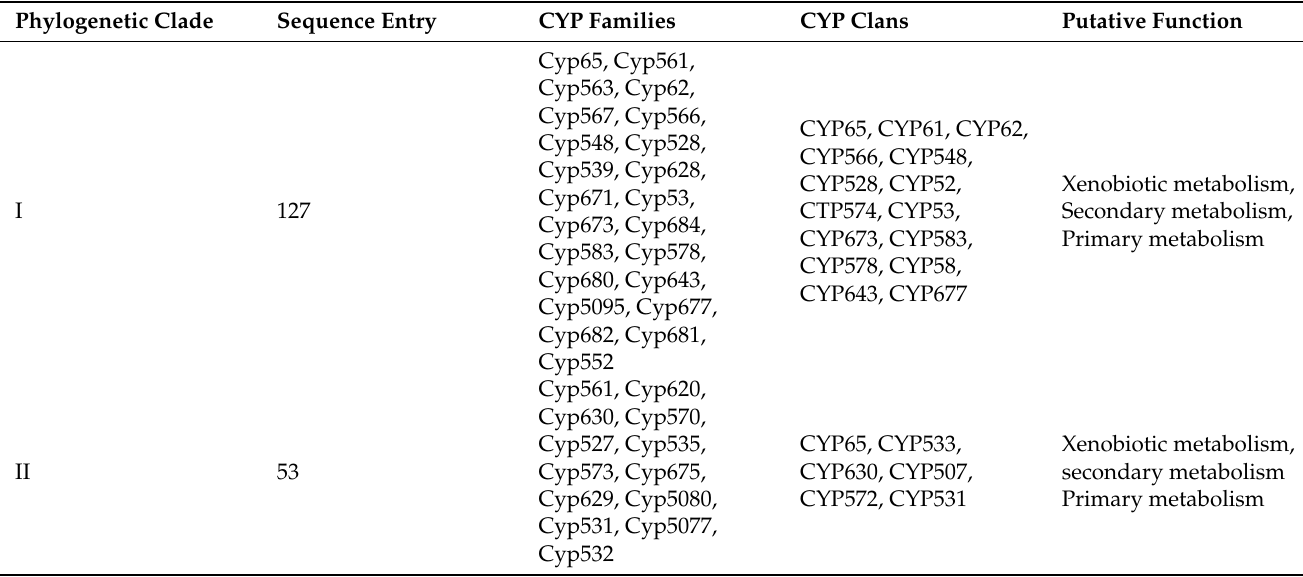
Figure 2. Evolutionary relationship of Cytochrome P450 genes in thirteen Alternaria species, which was inferred using MEGA X. Table 2. Phylogenetic clustering of Cytochrome P450 families and clans among thirteen Alternaria spp.